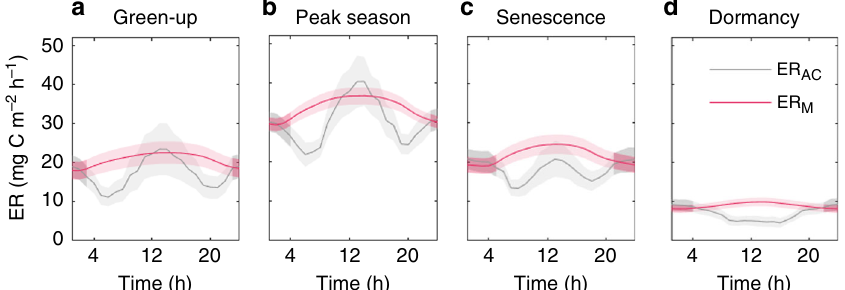
Fig. 1 Diel patterns of measured versus extrapolated ecosystem respiration. Diel patterns of ecosystem respiration (ER) measured by autochambers (ER AC ) and estimated by a standard fl ux modeling approach that extrapolated nighttime ER AC data to the daytime (ER M ) during the key phenophases of a green-up, b peak season, c senescence and d dormancy (spring and autumn) shown as a mean of the years 2015 – 2017 (see Supplementary Fig. 1 for ER AC results from individual years). Shaded bands indicate ±1 standard error for a given hour resulting from the variation within each phenophase and across the 3 years. Darker shading shows the nighttime hours of the diel cycle. ER M is modeled based on an exponential relationship between nighttime ER AC and air temperature using the REddyProcWeb online gap- fi lling tool (Wutzler et al. 26 ; see Methods for